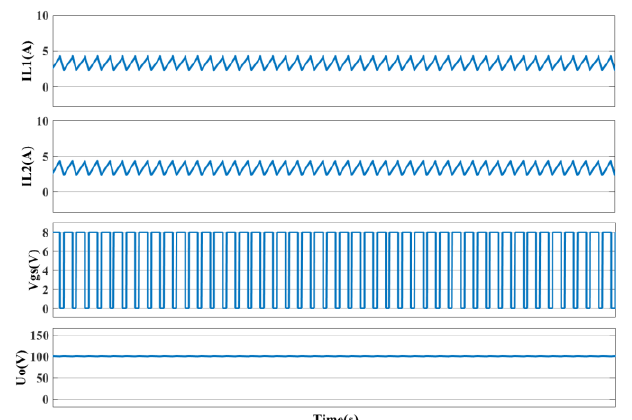
Figure 12. Simulation results of converter.